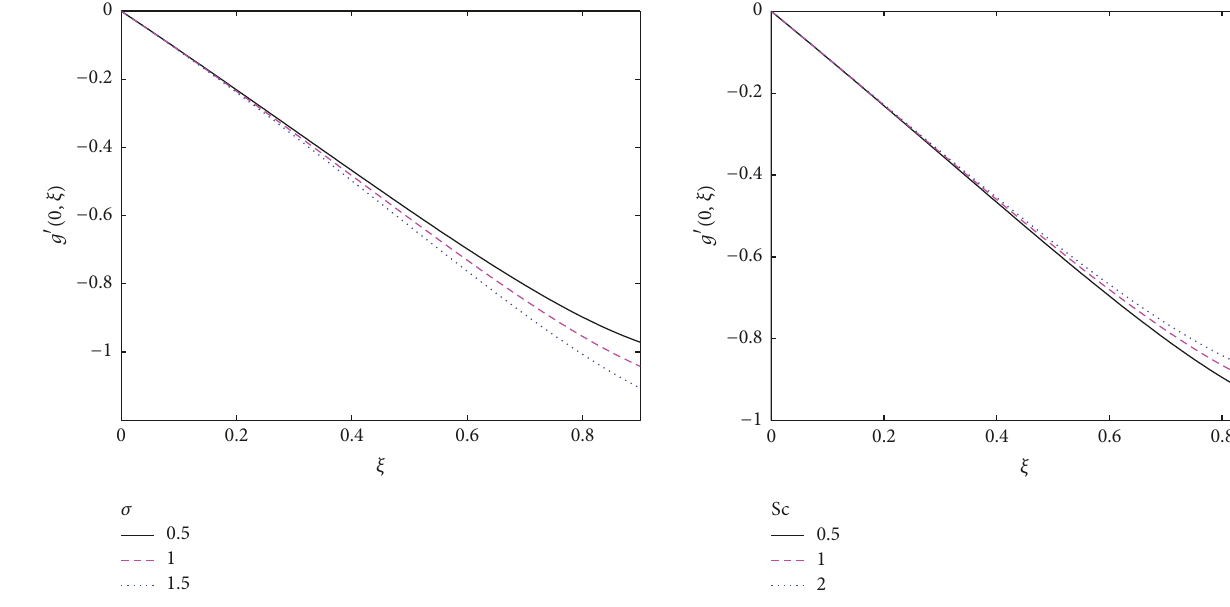
Figure 16: Effect of 𝜎 on 𝑔 󸀠 (0,𝜉) ( 𝜆 = 𝛾 = 0.5, Pr = 3, Sc = 2, ℏ = −0.5 ).